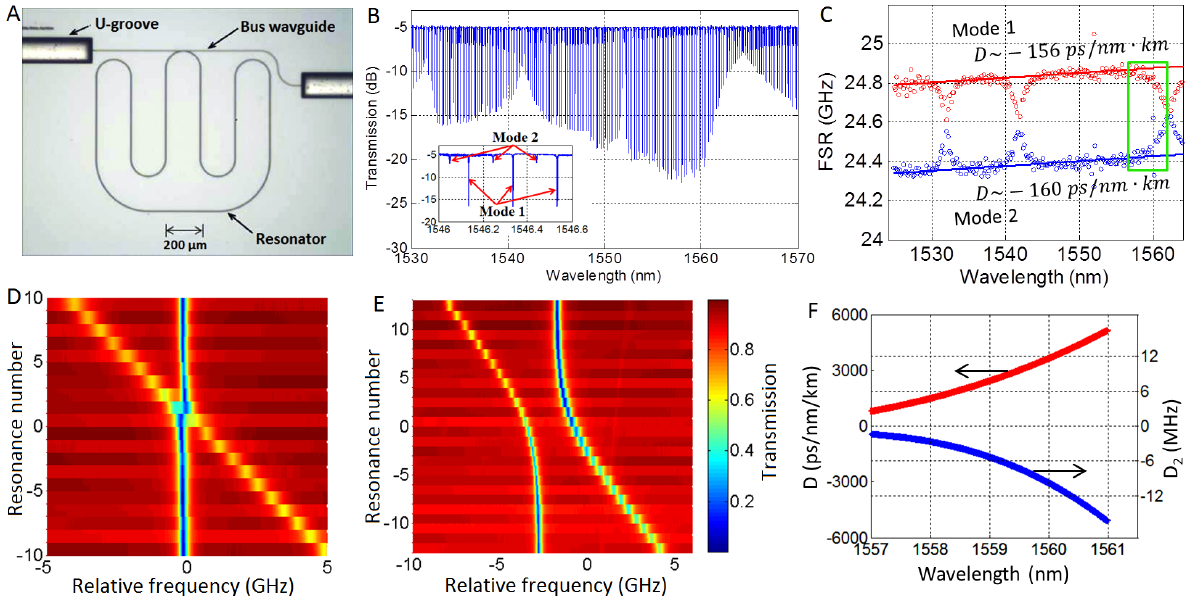
Figure 7: Experimental evidence of mode coupling in a Si 3 N 4 microring resonator. (A) Microscope image of the microring. (B) Transmission spectrum. (C) FSR versus wavelength for the two modes. (D) Zoom-in view of the transmission in the region around 1552 nm, showing weak mode coupling. (E) Zoom-in view of the transmission in the region around 1562 nm, showing strong mode coupling. (F) Local dispersion retrieved from the FSR slope for mode 1 in the strong mode coupling region around 1562 nm (marked with a green box in (C)). Adapted from Ref. [45]. FSR: free spectral